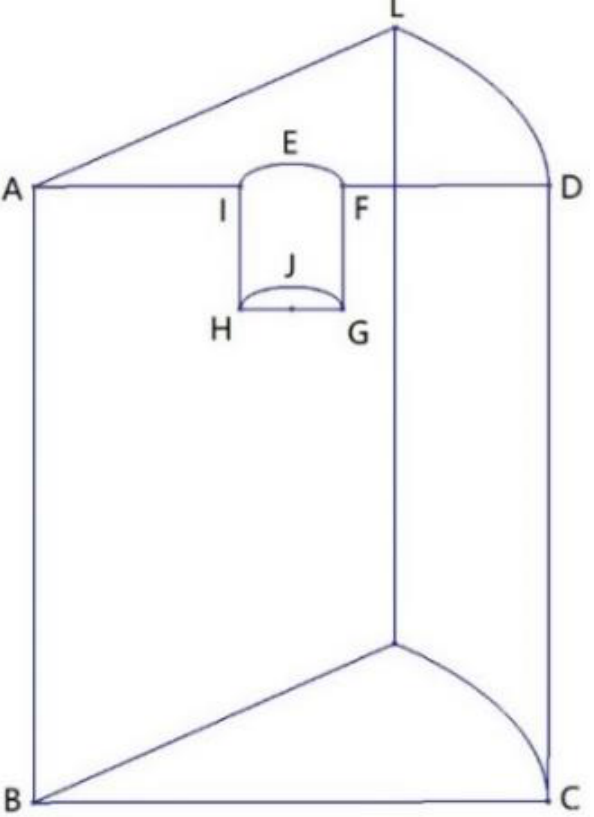
Figure 5. Field layout of water storage pit irrigation.